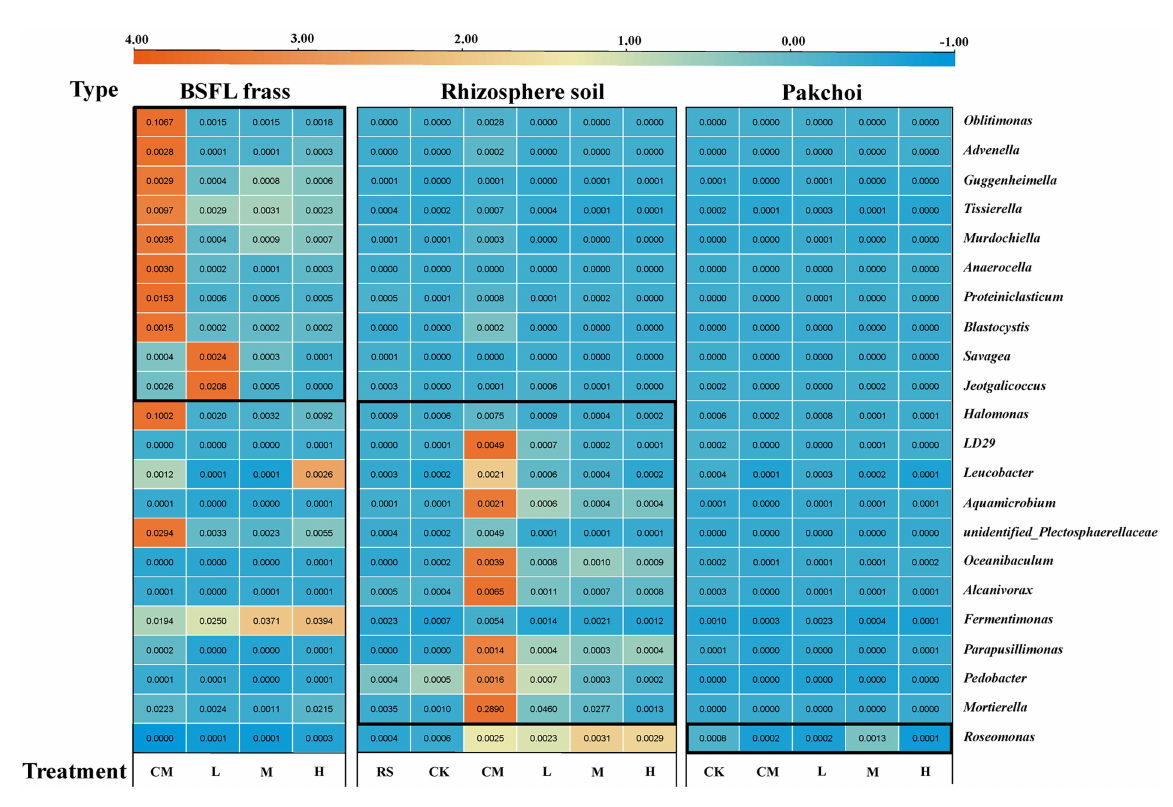
FIGURE 5 Relative abundances of 22 potential host microorganisms in BSFL frass, rhizosphere soil, and pakchoi endophytes with high correlation (correlation at least greater than 0.9, except for pakchoi endophyte samples, which are only greater than 0.8) among different treatments. “RS” means initial pure soil, “CK” means untreated soil, “CM” means untreated manure without BSFL, “L” means 50 BSFL cultured in 100 g of fresh manure, “M” means 100 BSFL cultured in 100 g of fresh manure, “H” means 1,000 BSFL cultured in 100 g of fresh